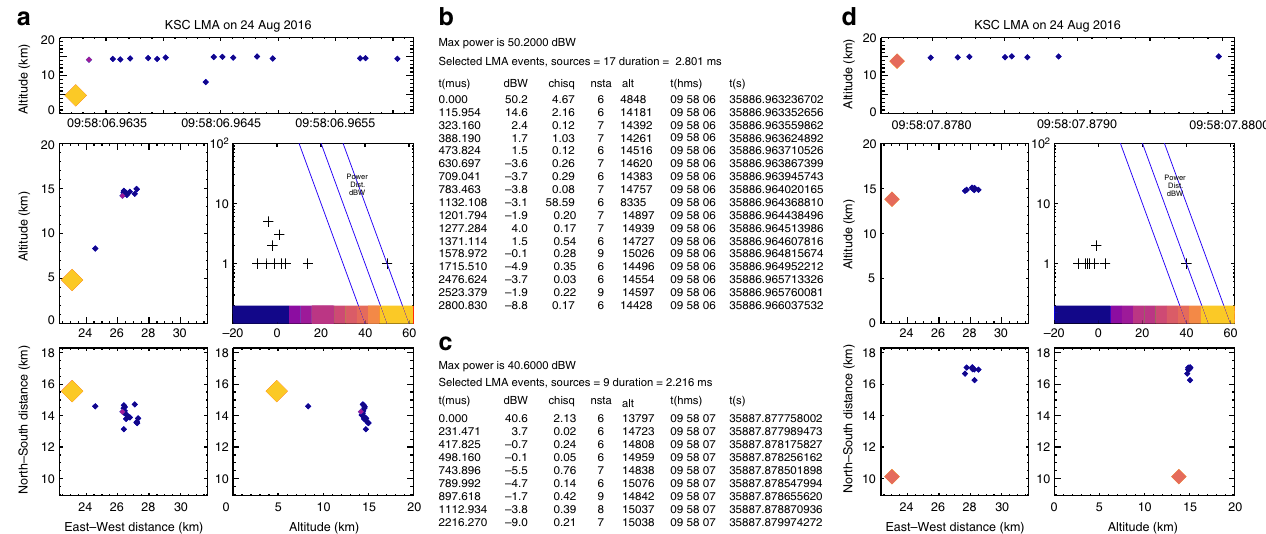
Fig. 8 Detailed lightning mapping data for NBEs 1 and 2. a , d LMA maps of the complete activity for each of the two NBE-initiated discharges, showing how the NBEs are mis-located relative to the subsequent, lower-power activity, and how the subsequent activity more accurately indicates the NBEs actual location. b , c Numerical listings of the source times, power (in dBW), goodness-of- fi t χ 2 ν (chisq) value, and number of stations (nsta) participating in the